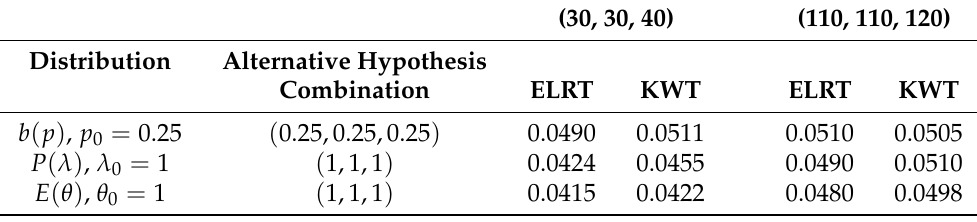
Table 3. Rejection rates ELRT and KWT under sample sizes ( 30,30,40 ) and ( 110,110,120 ) and corresponding null